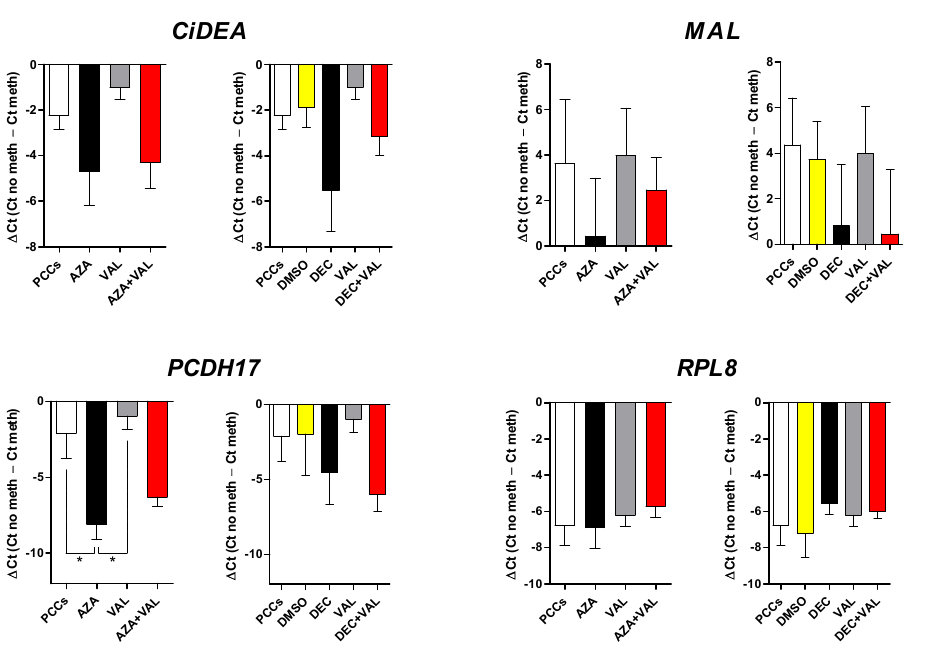
Figure 6. Effect of the treatment with AZA or DEC in combination with VAL on CiDEA, MAL,